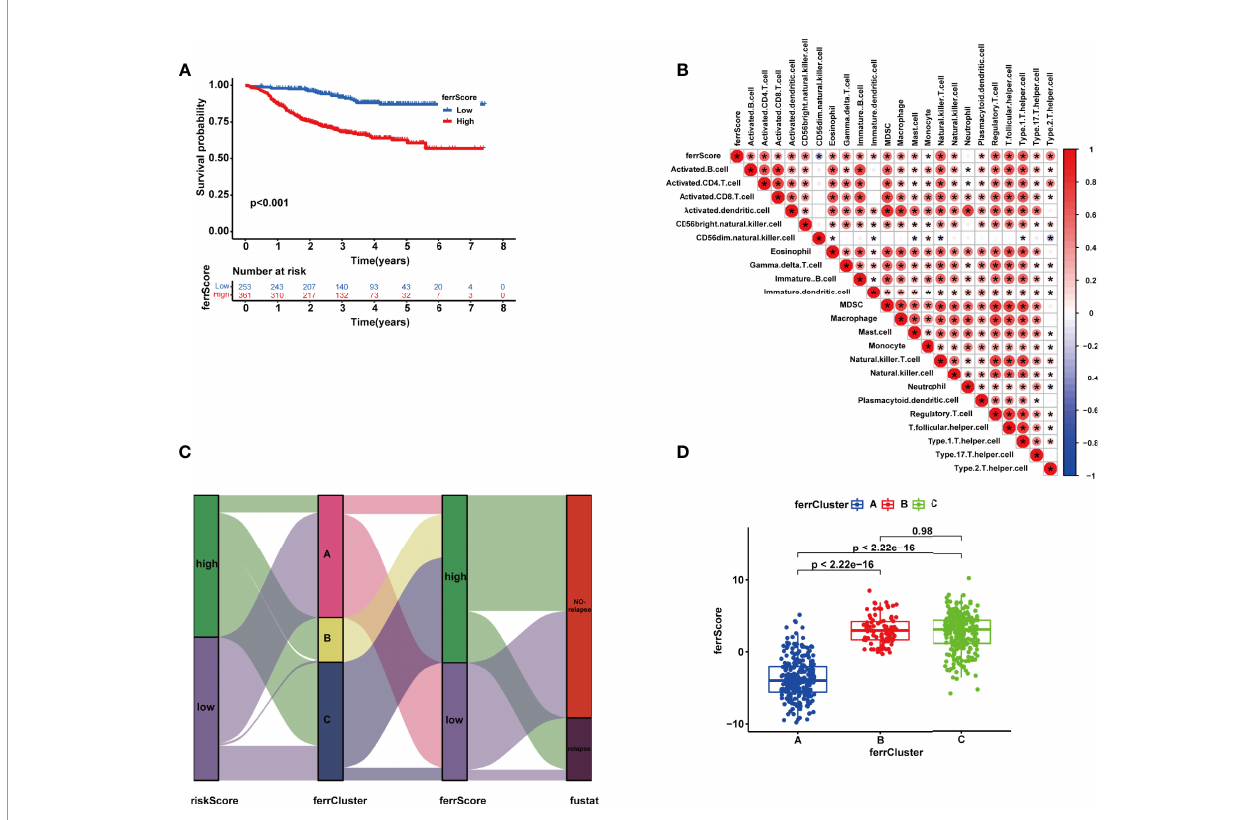
FIGURE 7 | (A) Kaplan – Meier (K-M) curve of the survival difference between high and low ferrScore groups. (B) Correlation between immune cells and ferrScore. (C) Alluvial diagram of riskScore group, ferrCluster group, ferrScore group, and relapse-free status. (D) Correlation between ferrCluster and ferrScore *, P <